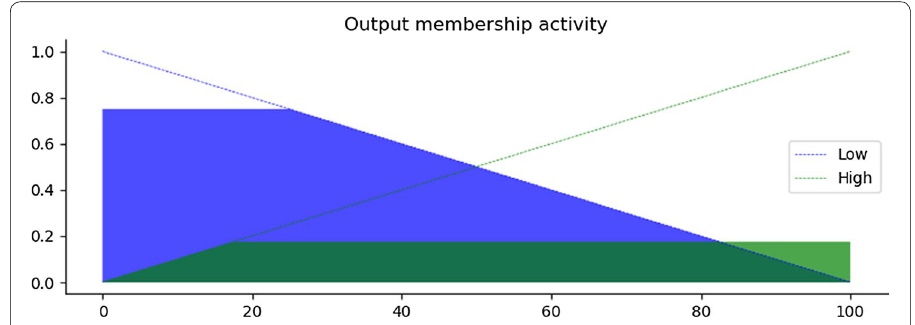
Fig. 3 Membership function for output based on model rules